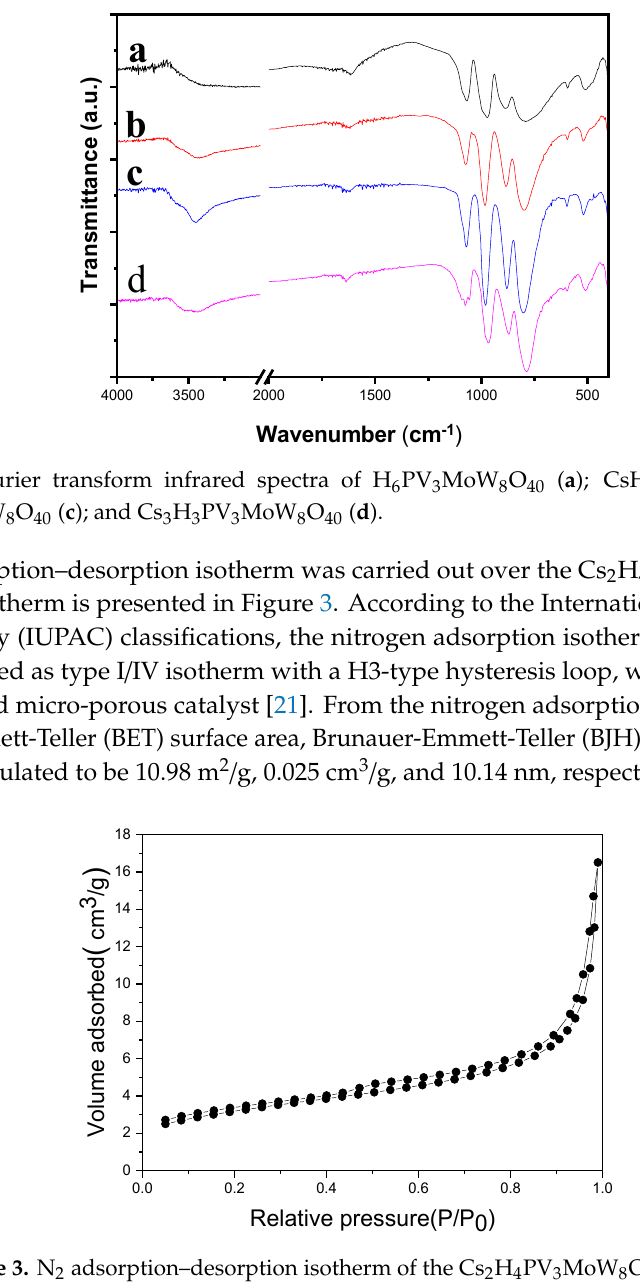
Figure 3. N 2 adsorption–desorption isotherm of the Cs 2 H 4 PV 3 MoW 8 O 40 catalyst.